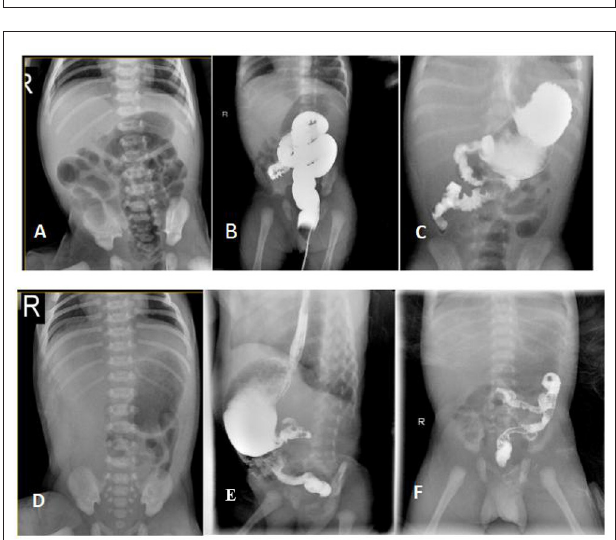
FIGURE 2 | Radiological findings of the patients with CSBS. [The proband] (A) X-ray abdomen showing the gas-filled stomach and the intestinal loops; (B) Lower gastrointestinal radiography showing the distribution of the colon predominantly in the center and on the left side of the abdomen; (C) UGI showing the upper part of the jejunum located on the right side of the abdomen in a spiral pattern. [The younger brother] (D) X-ray abdomen showing minimal gas in the stomach with no obvious gas shadows in the intestine. (E,F) UGI showing the ascending part of the duodenum and the upper part of the jejunum in a spiral